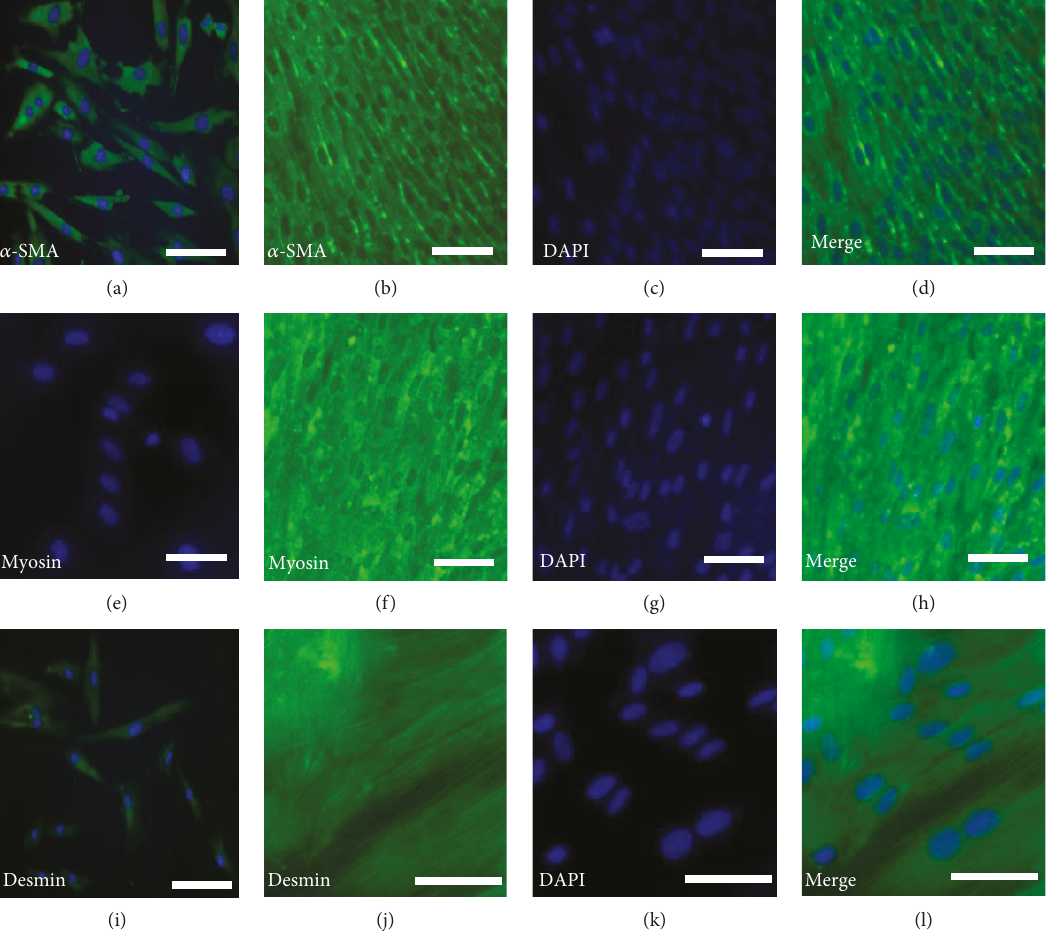
Figure 2: The smooth muscle layer-like phenotype generated by the dental pulp stem cell (DPSC) clone A32 after SMC induction. After a long period of di ff erentiation (20 days), the induced A32 formed a monolayer and generated the smooth muscle-like phenotype which was positive for expression of the SMC markers, α -SMA (b – d), myosin (f – h), and desmin (j – l). Noninduced A32 as the negative control (a, e, i). The green staining indicates a positive result. Nuclei were stained with DAPI. Bars: 50 μ